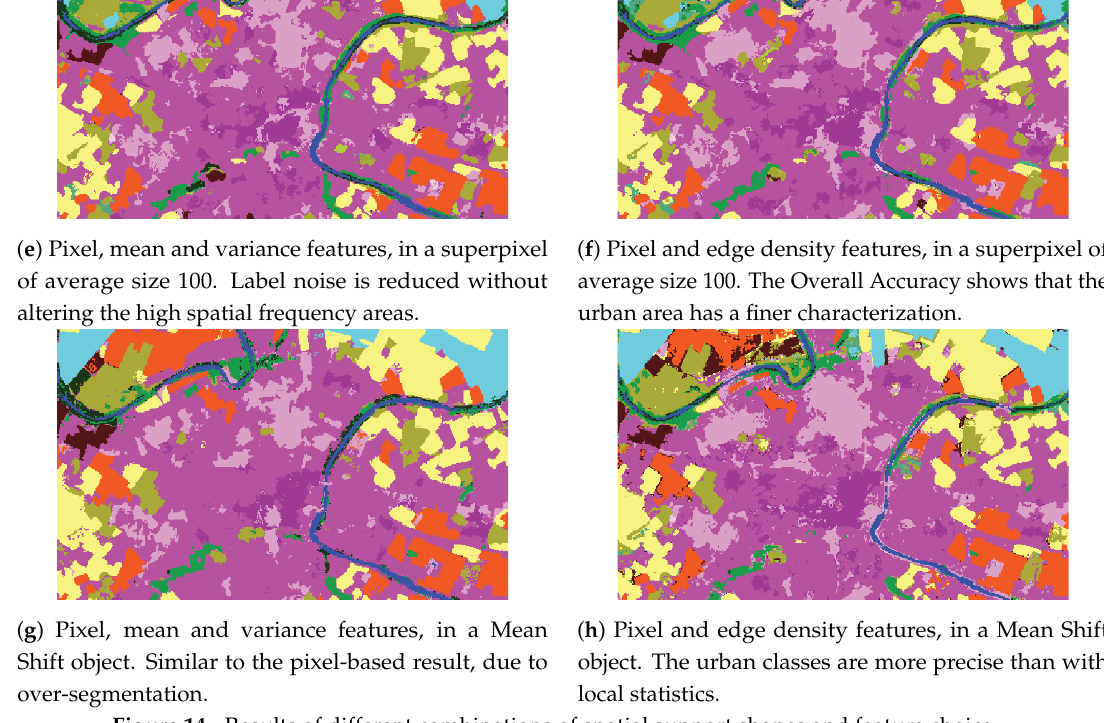
Figure 14. Results of different combinations of spatial support shapes and feature